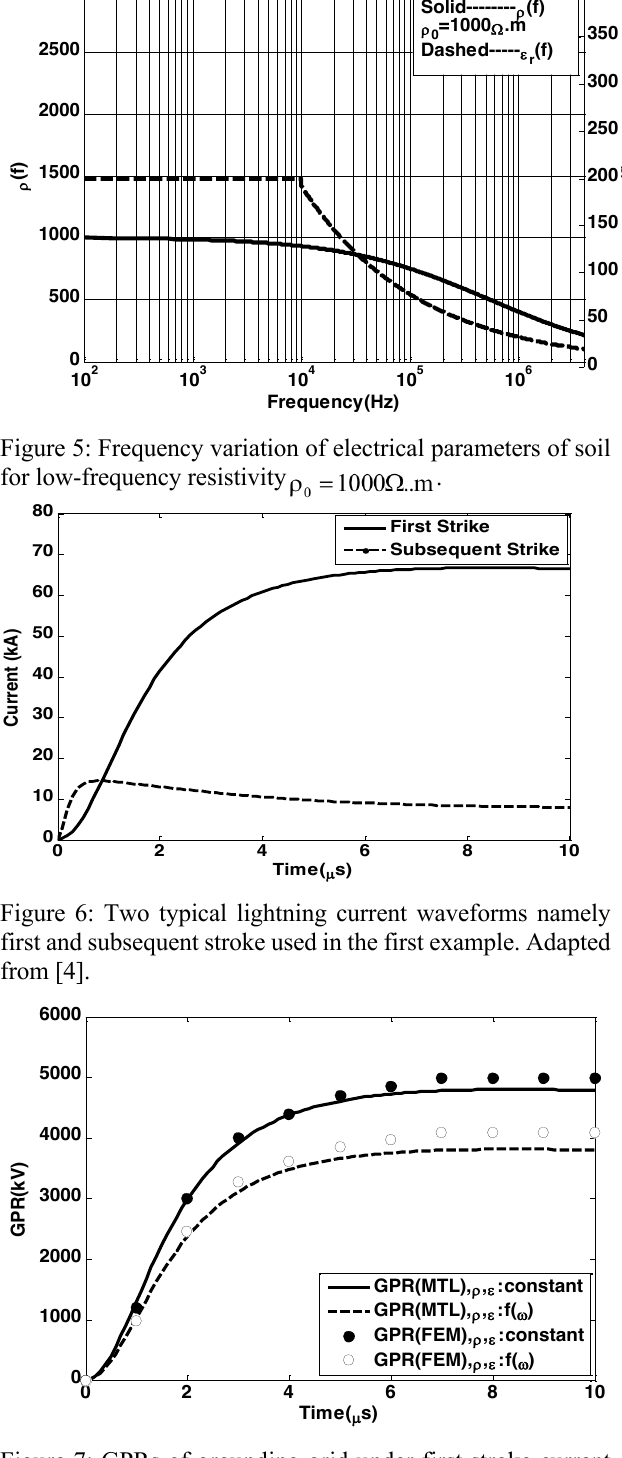
Figure 7: GPRs of grounding grid under first stroke current using MTL and comparision with FEM [4].